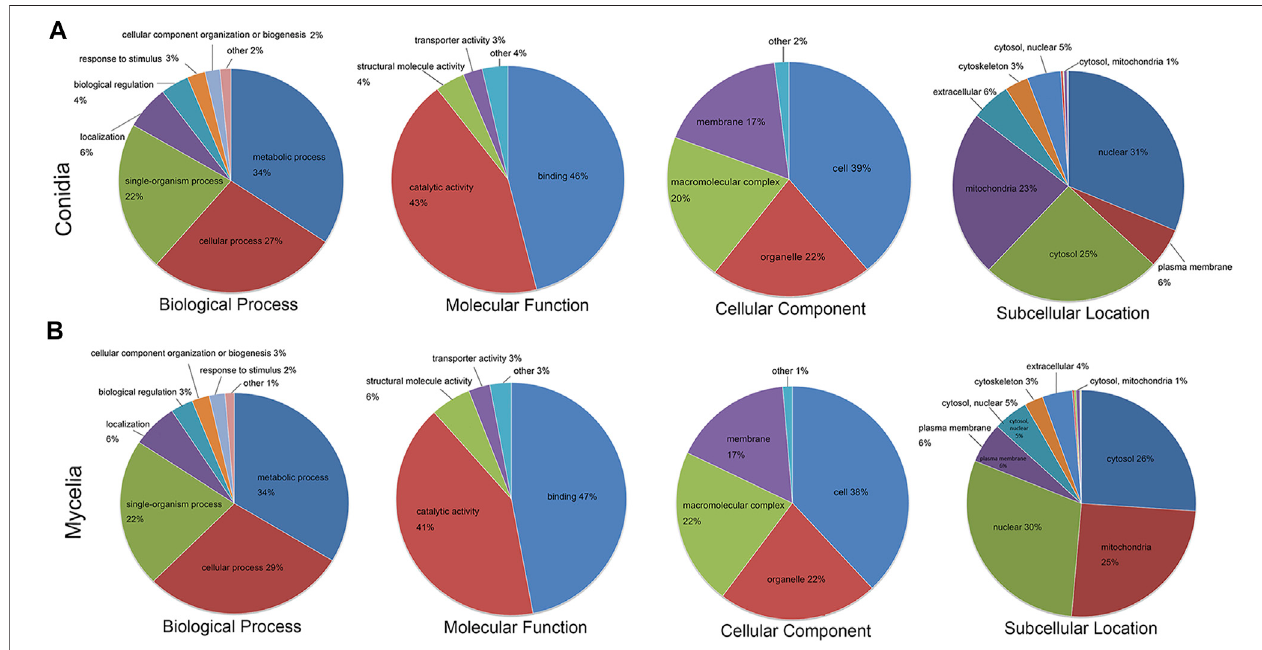
FIGURE 3 | Functional annotation of the crotonylated proteins. GO biological process, molecular function and cellular component classi fi cations, and subcellular localization analysis of the crotonylated proteins. The crotonylated proteins in the (A) conidial stage and (B) mycelial stage were subjected to differentiate function classi fi cation.